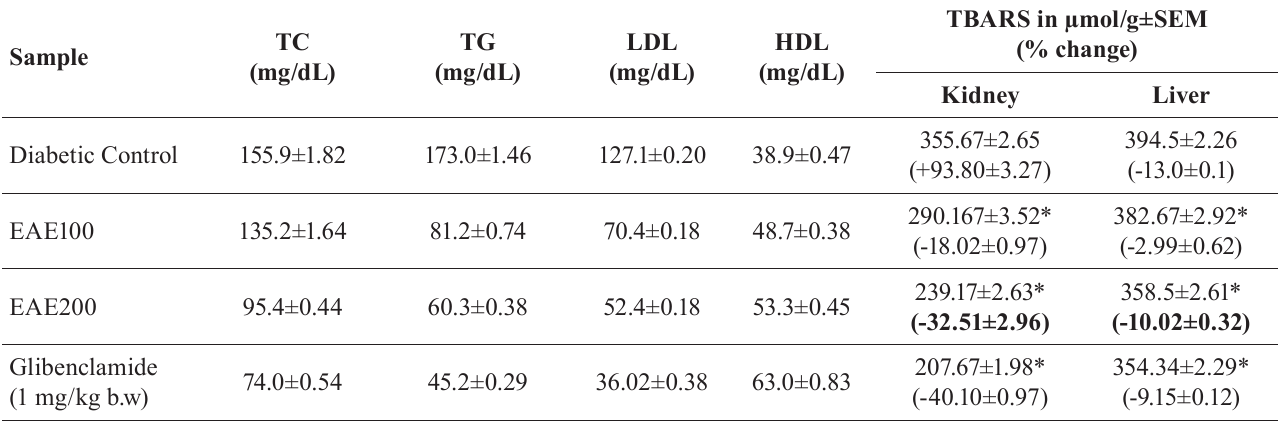
TABLE IV – The serum glucose concentrations, total cholesterol (TC), triglycerides (TG), High density lipoprotein (HDL) and low density lipoprotein (LDL) cholesterol levels and TBARS contents in diabetic rats due to the effect of ethyl acetate extract of C. baltica